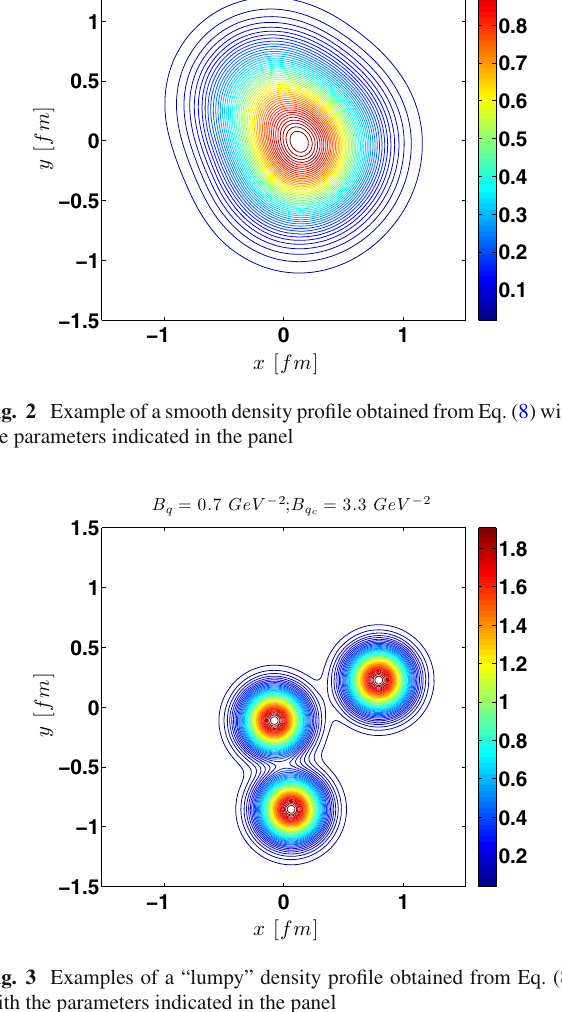
Fig. 5 are obtained. The incoherent cross section is largely underestimated, while the calculated coherent cross section reproduces the HERA data. This just confirms the